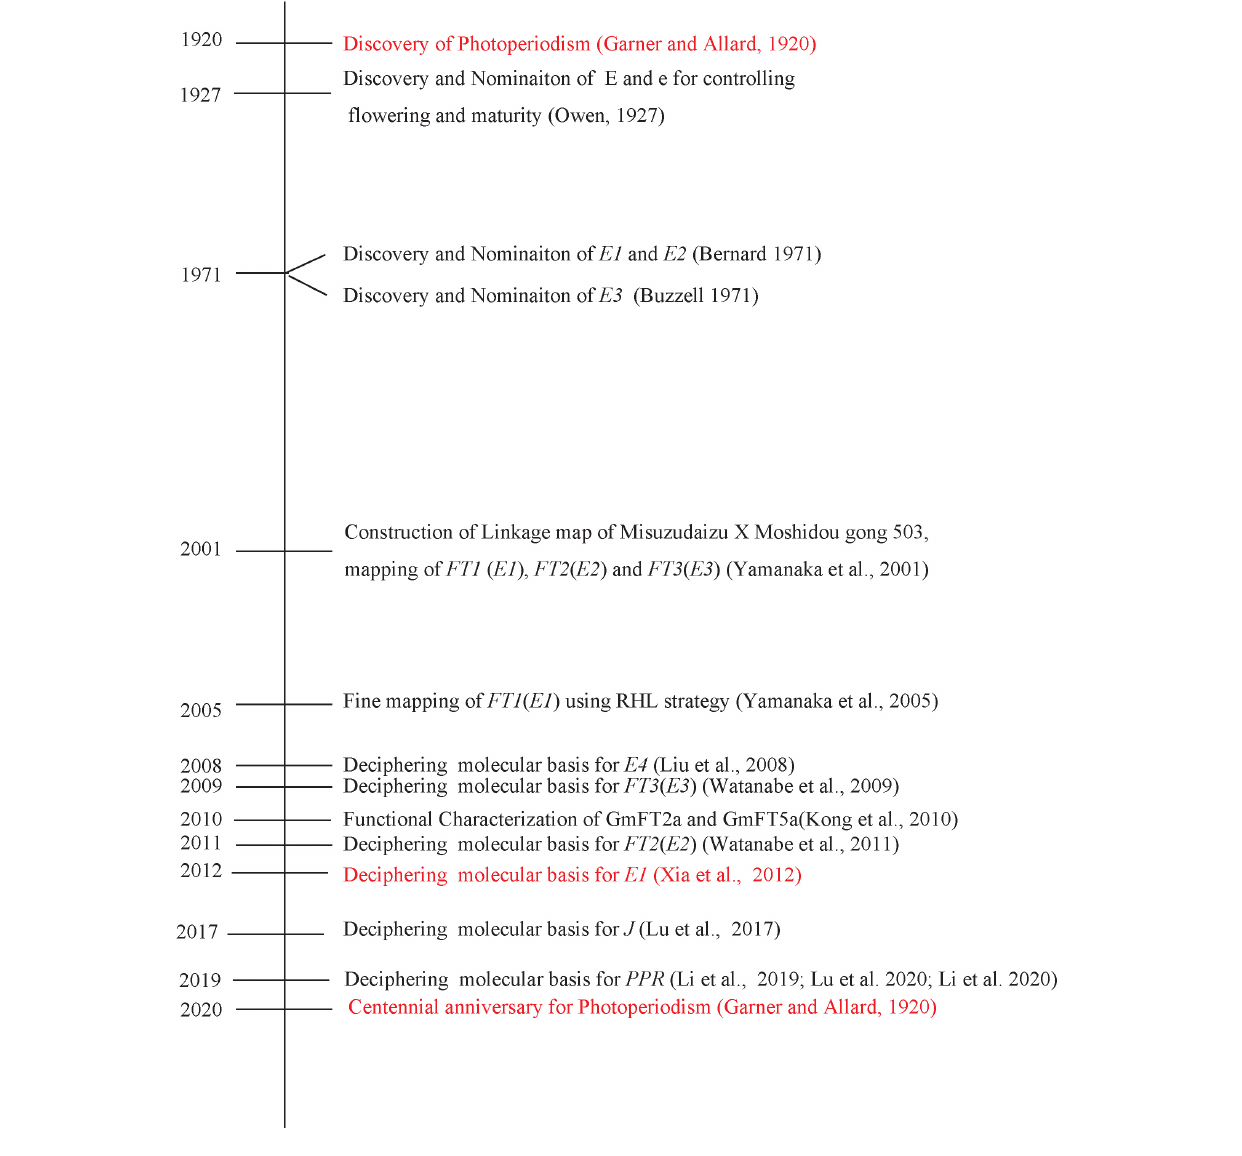
FIGURE 7 | The important research events in soybean since the discovery of the